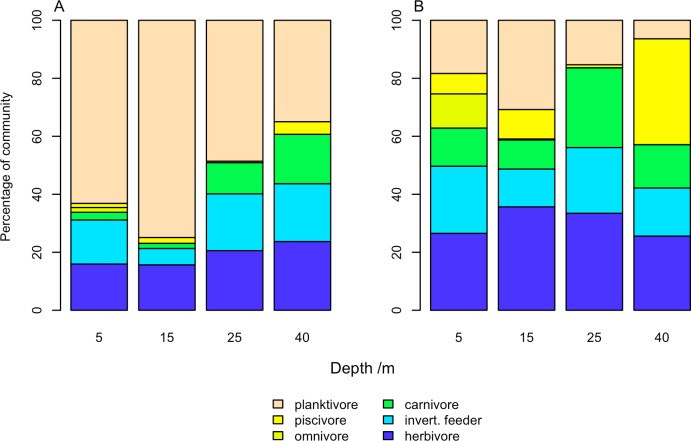
Change in percentage of different trophic groups with depth.Fish community was weighed by (A) abundance and (B) biomass. Percentage abundance and biomass of each trophic group was calculated by summing all fish identified on all transects at all sites in a depth band.